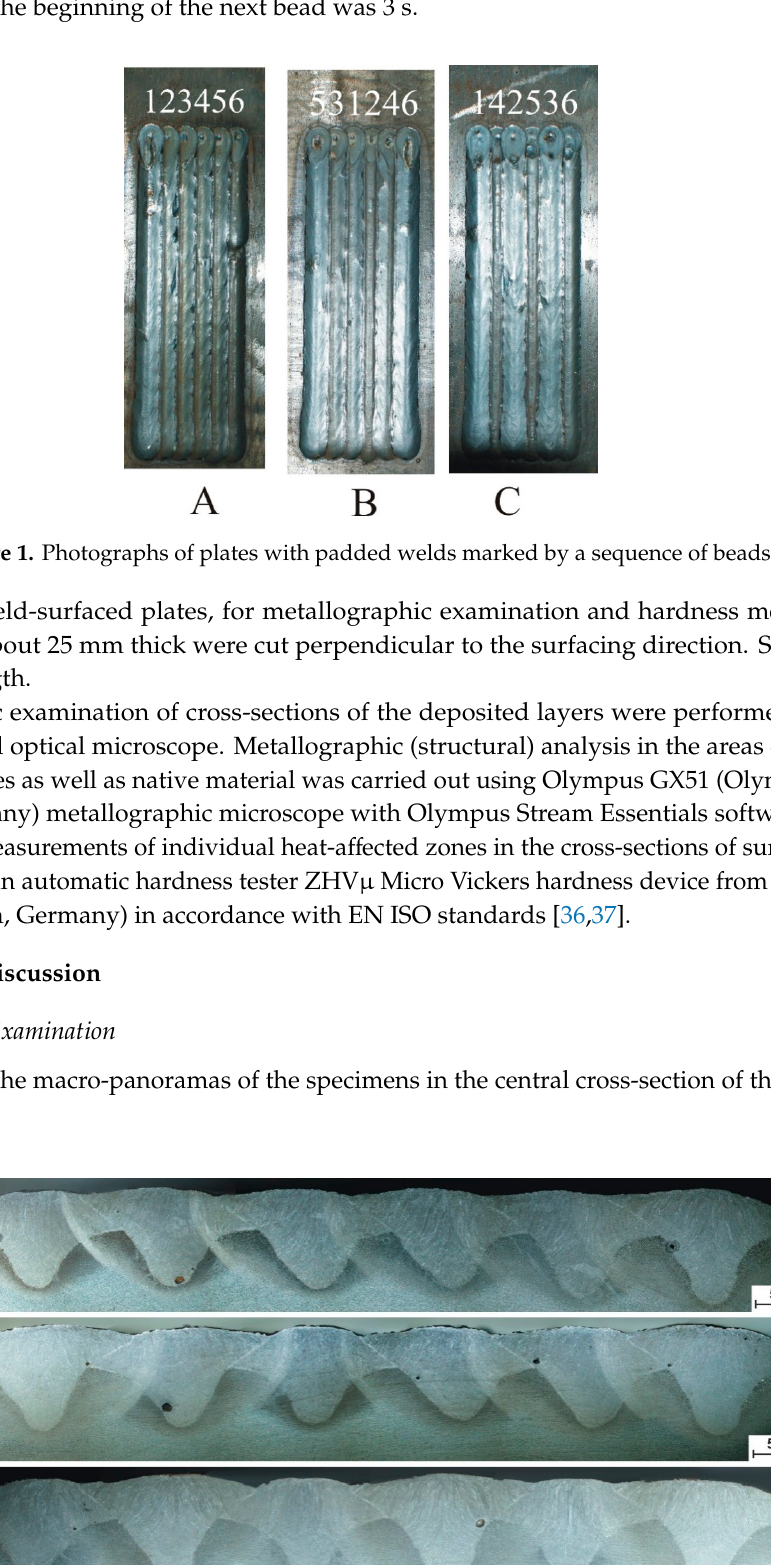
Figure 2. Macro-panoramas of the metallographic specimens in the middle cross-section of the plates.